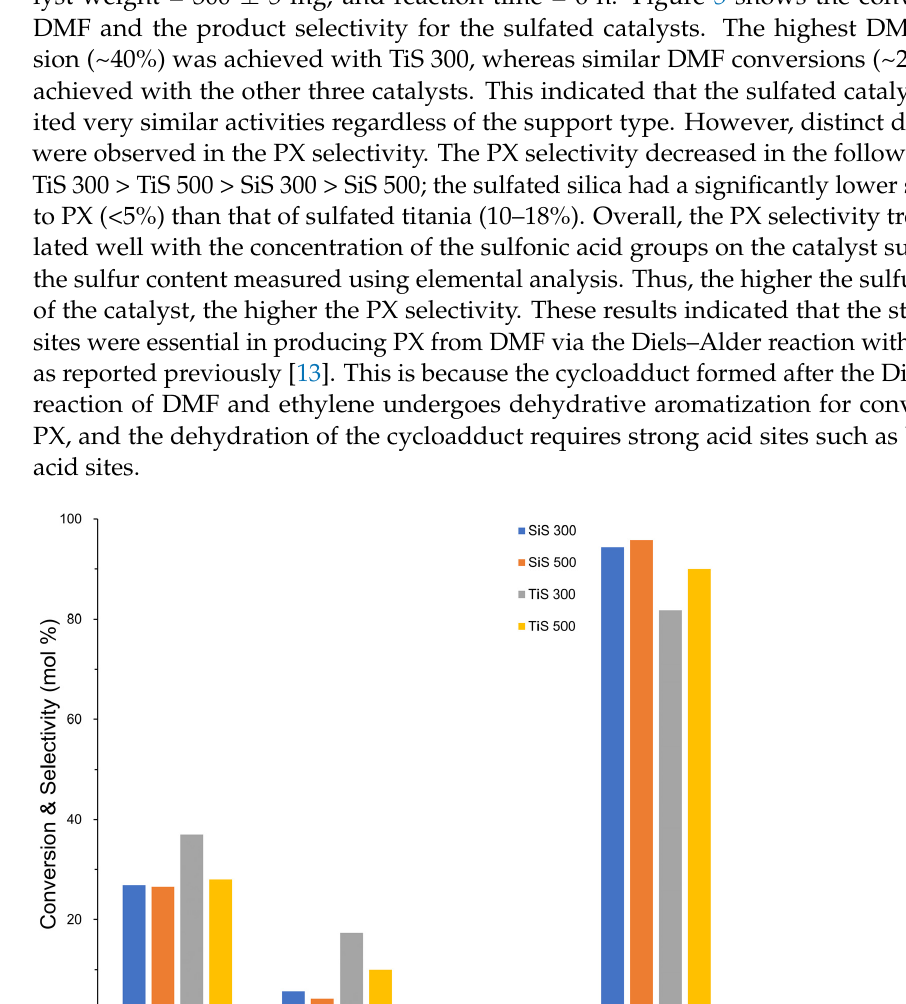
Figure 6. Conversion of DMF and selectivity of PX and HDO for the Diels–Alder reaction of DMF and ethylene over phosphated catalysts. Reaction condition; temperature = 523 K, reaction time = 6 h, C 2 H 4 pressure = 30 bar, DMF = 11.1 wt. %, catalyst mass = 300 ± 5 mg.